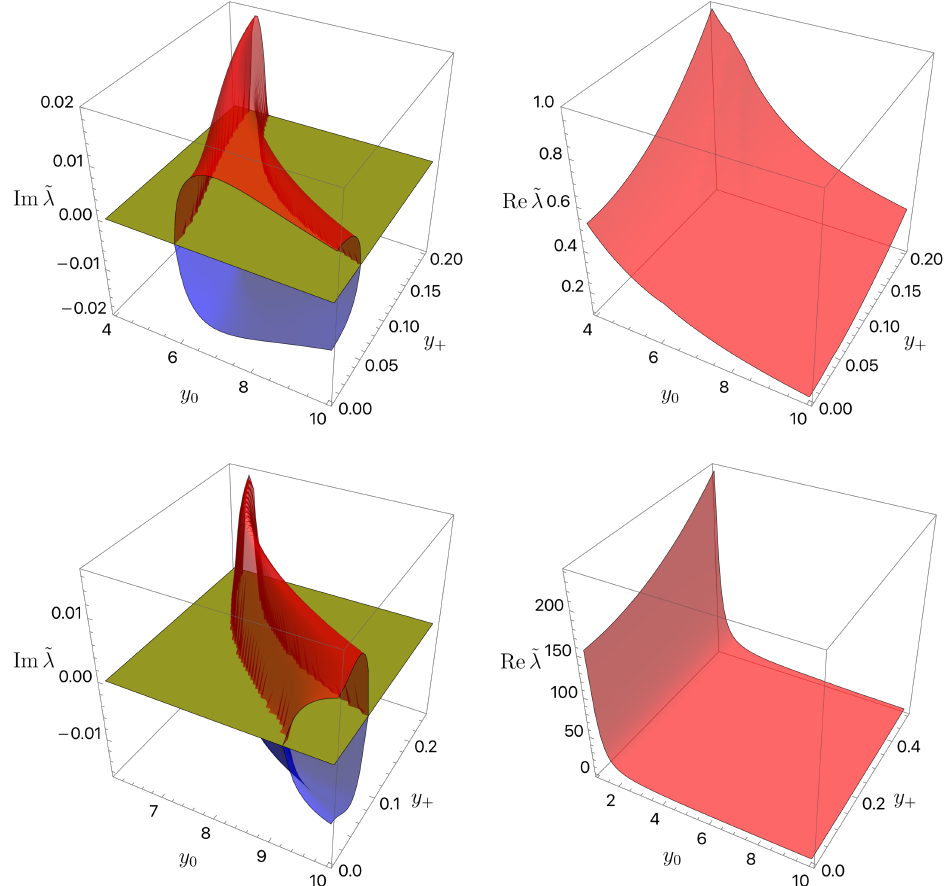
Figure 5 . The imaginary part (left column) and the imaginary part (right column) of the first excited mode in a region of y 0 and y + where the mode is complex. The top row has d = 4 , while the bottom row has d = 5 . The green horizontal plane on the left column sits at e λ = 0 and is just there for illustration purposes. The mode with Im e λ > 0 is represented in red, while for Im e λ < 0 we represent the mode in